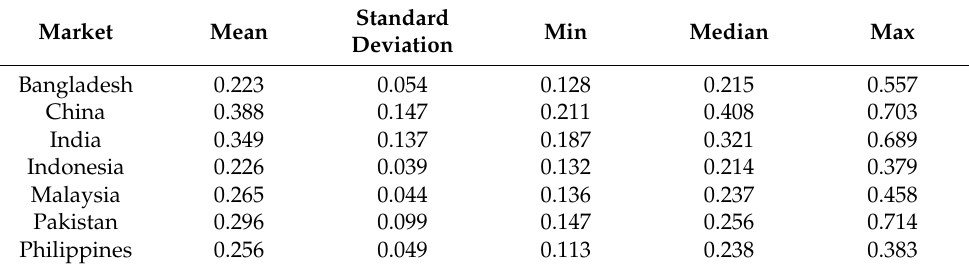
Table 2. Results of market levels R 2